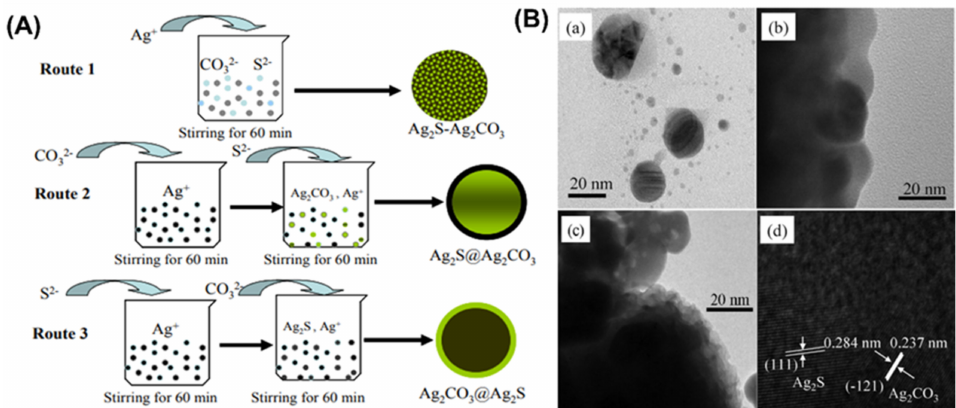
Figure 3. ( A ) Fabrication of Ag 2 S-Ag 2 CO 3 , Ag 2 CO 3 @Ag 2 S, and Ag 2 S@Ag 2 CO 3 composite photo- catalysts by coprecipitation/successive precipitation route. ( B ) Photograph showing TEM images of ( a ) Ag 2 S; ( b ) Ag 2 CO 3 ; ( c ) 32%Ag 2 S@ Ag 2 CO 3 . ( d ) High-resolution image of 32%Ag 2 S@Ag 2 CO 3 . Reproduced with permission from